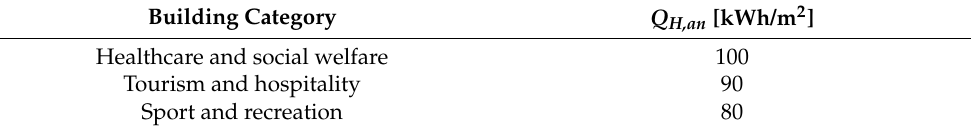
Table 4. Maximum values for annual energy needs for heating for mandatory EPC class C